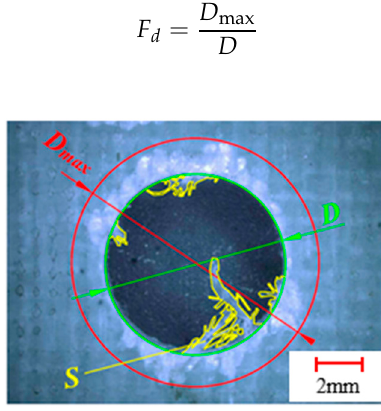
Figure 9. Measurement of delamination factor and burrs area.